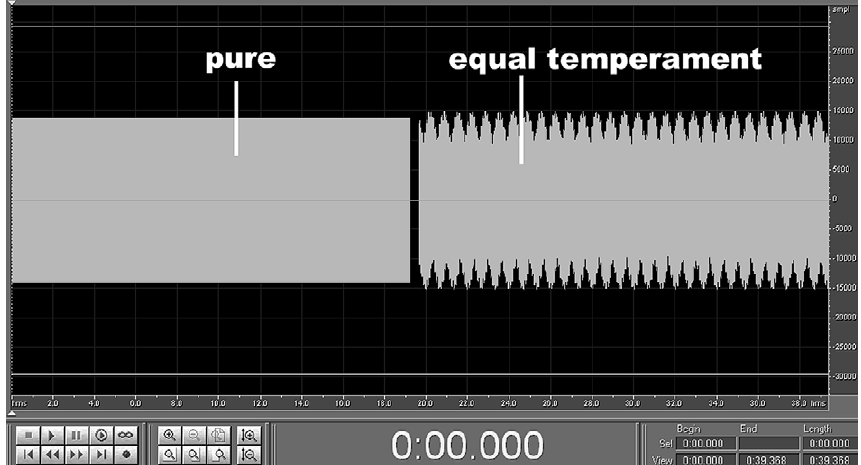
Figure 4. Different wave ‘ envelopes ’ for a chord with pure tuning and equal